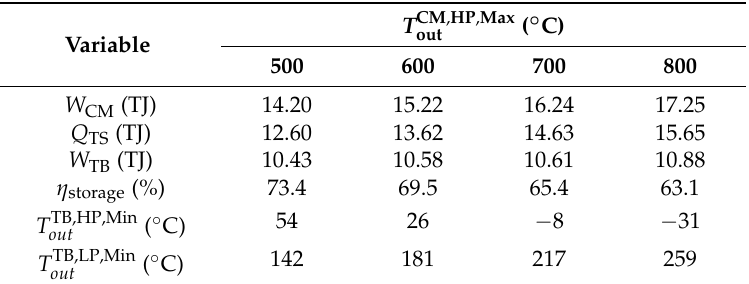
Table 4. Sensitivity of the A-CAES performance to the maximum discharge temperature of the high-pressure compressor ( T CM,HP,Max out